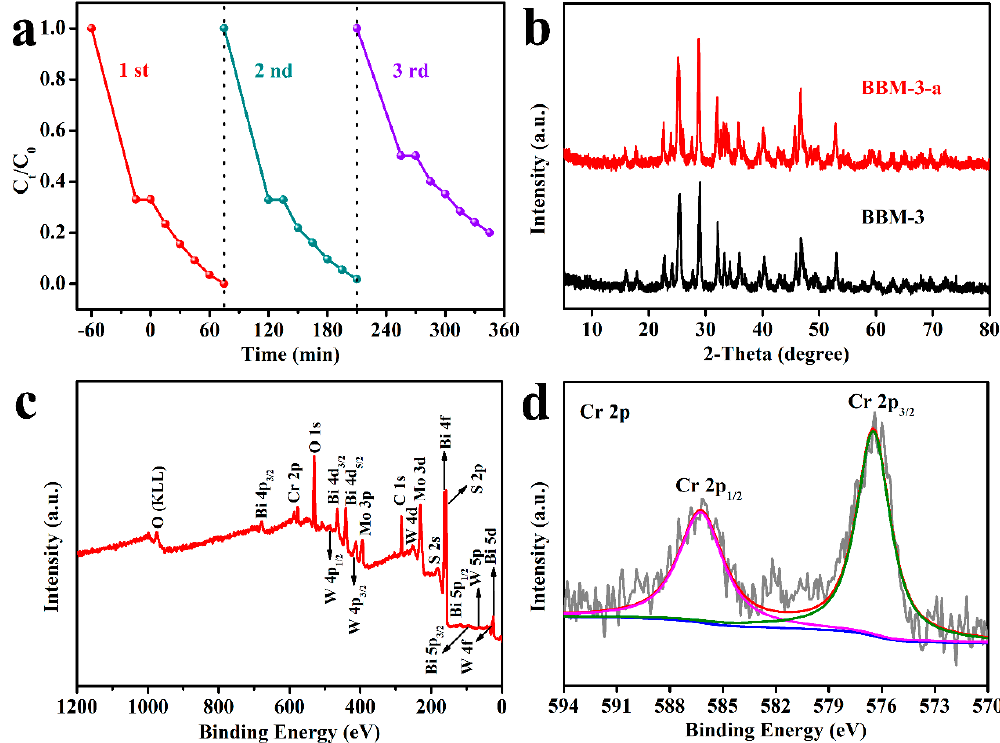
Figure 8. ( a ) Vis-light catalytic reduction of Cr(VI) by BBM-3 at different recycling runs. ( b ) XRD pattern of the BBM-3 and BBM-3-a. XPS spectra of BBM-3-a: ( c ) survey and ( d ) Cr 2p.